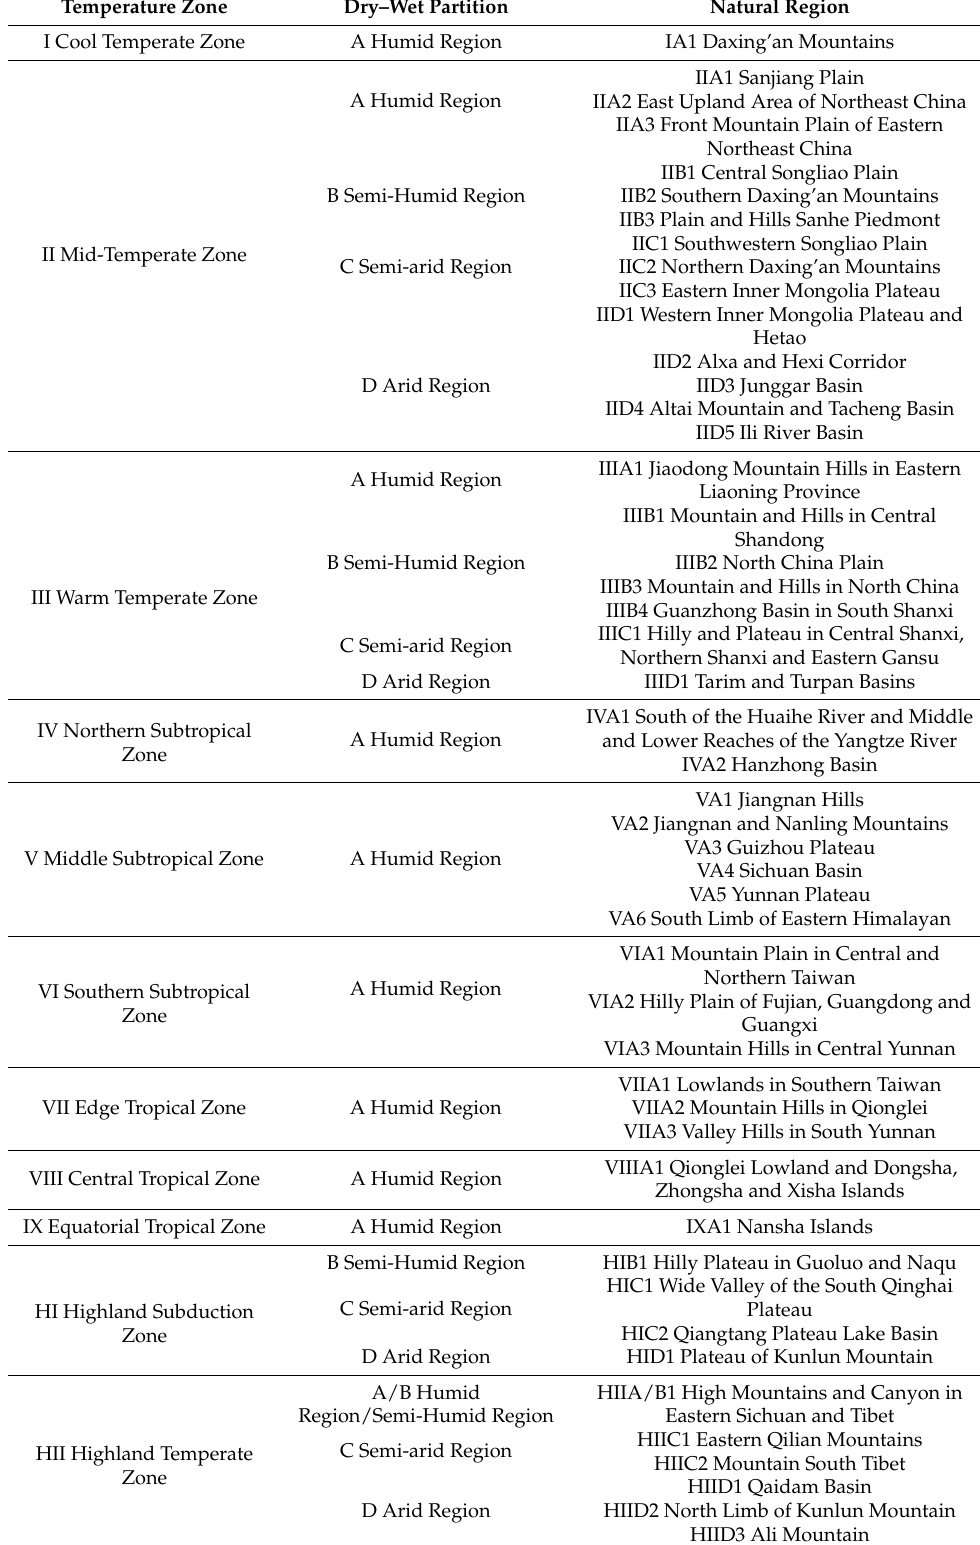
Table 1. Codes of eco-geographical